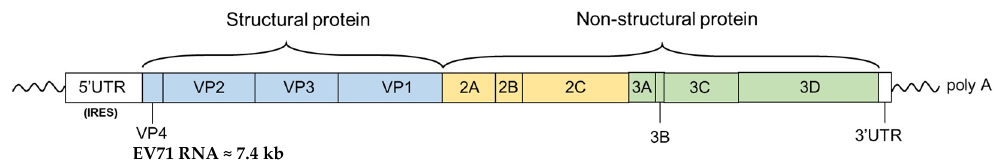
Figure 1. The genomic organization of EV71. The plus-strand RNA of EV71 genome encodes a single polyprotein precursor. Upon proteolytic processing by virus-encoded proteases 2A and 3C, this polyprotein precursor converts into several smaller mature products, including 4 structural proteins (VP1-VP4 capsid protein) and 7 non-structural proteins (2A, 2B, 2C, 3A, 3B, 3C and 3D). 3B encodes a VPg protein, which is covalently bound to the 5′ end of the RNA genome. 3D encodes RNA-dependent RNA polymerase. IRES: internal ribosome entry site. This cartoon illustration is based on gt B5 clinical isolates in Taiwan [4,5]. However, it is representative of the general genomic structure of all genotypes isolated elsewhere.